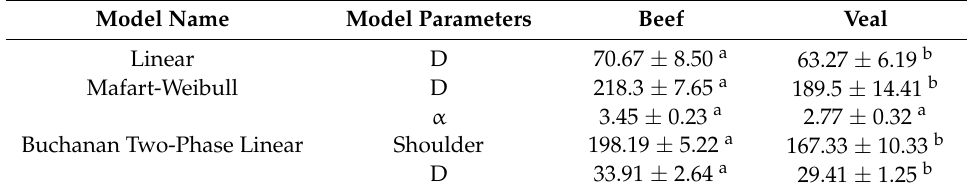
Table 6. Parameters (mean ± standard error) of survival models estimated for the inactivation of E. coli O157:H7 in ground beef and veal patties after double pan-broiling at 177 ◦ C (350 ◦ F) for 0 to 360